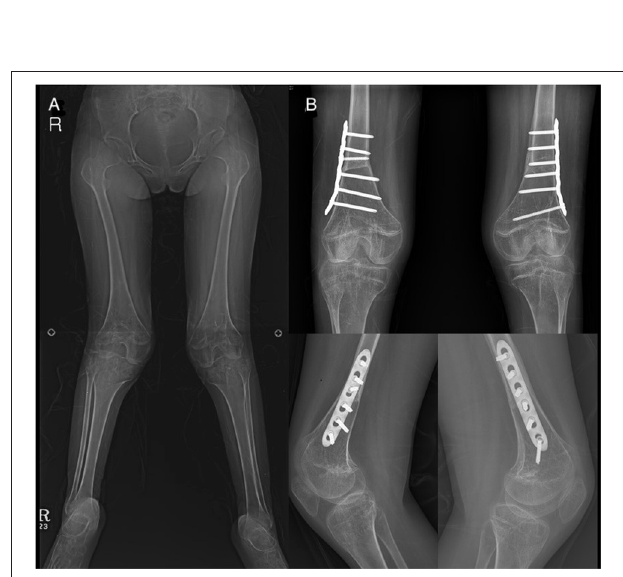
FIGURE 3 | Patient (no. 14) who underwent concomitant knee surgeries. (A) Genu valgum deformity. (B) Correction with femoral extension and varus